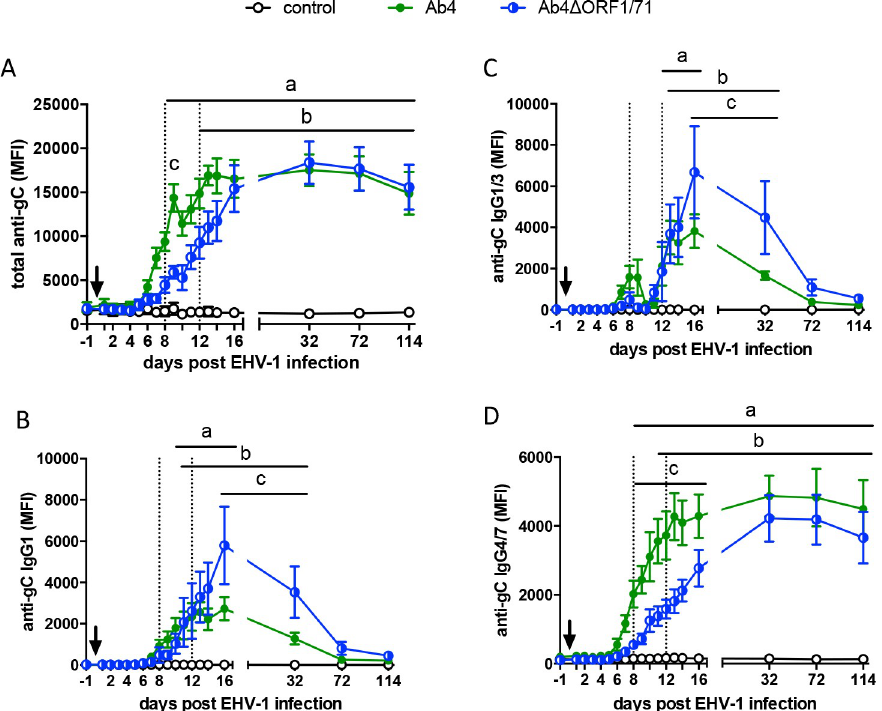
Fig 3. Total anti-EHV-1 gC and IgG isotype responses in serum from horses after infection with the EHV-1 strain Ab4 or its deletion mutant Ab4 Δ ORF1/71. EHV-1 na ï ve horses (n = 5 per group) were infected with the EHV-1 strain Ab4 or Ab4 Δ ORF1/71. Non-infected horses were kept as controls. The arrow marks the time of infection on d0. Serum antibodies were measured by an EHV-1 Multiplex assay. Antibody values are expressed as median fluorescence intensities (MFI) for (A) total Ig, (B) IgG1, (C) IgG1/3, and (D) IgG4/7. All graphs show means and standard errors by group over time. The dotted vertical lines mark d8 and d12pi to illustrate the time of the onset of the response for total Ig and the different IgG isotypes. Significant differences between the groups are shown: a = Ab4 vs. controls, b = Ab4 Δ ORF1/71 vs. controls, and c = Ab4 vs. Ab4 Δ ORF1/71.